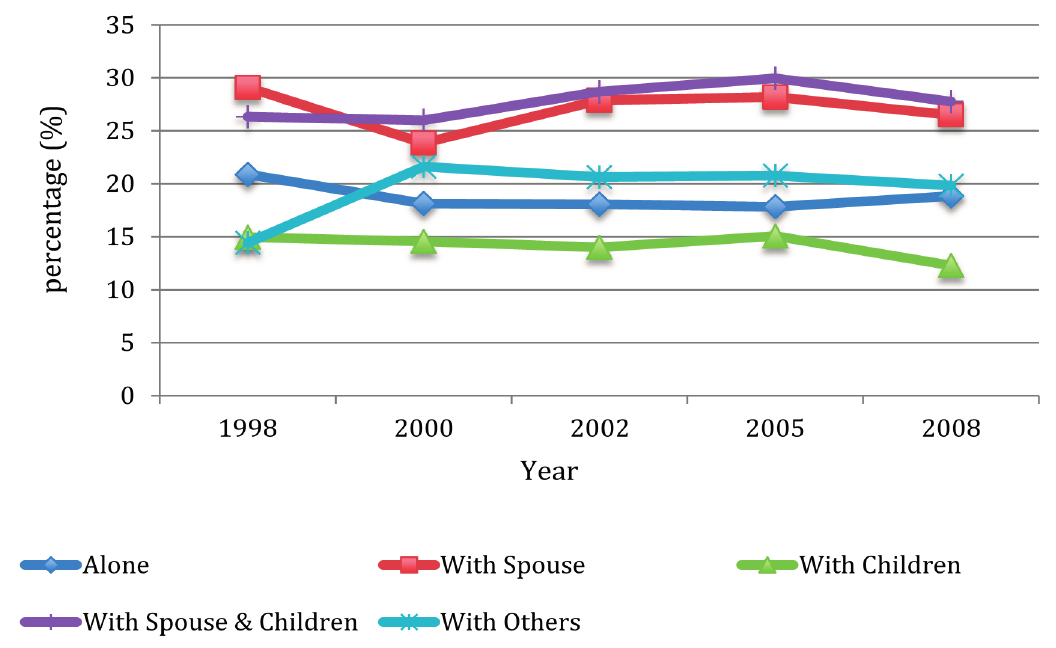
Figure 2. Percentage of drinking by wave and by living